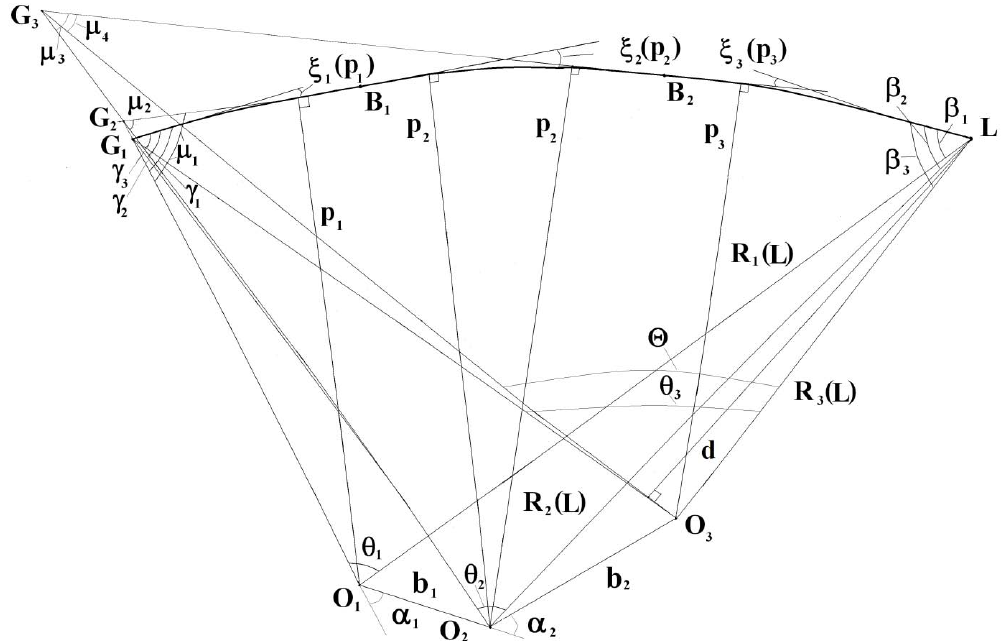
Fig. 9. Geometry of electromagnetic wave propagation through three spherical symmetric sectors. The points G 1 , B 1 , B 2 , L are supposed to be located in the same plane with the centers of spherical symmetry O 1 , O 2 , O 3 . The points G 2 , G 3 are intersections of the tangents to the ray trajectory G 1 B 1 B 2 L at the points B 1 , B 2 with the straight lines G 1 O 1 and G 2 O 2 respectively. The angle 2 has vertex at point O 3 . The value 2 determines the angle between the directions G 3 O 3 , and LO 3